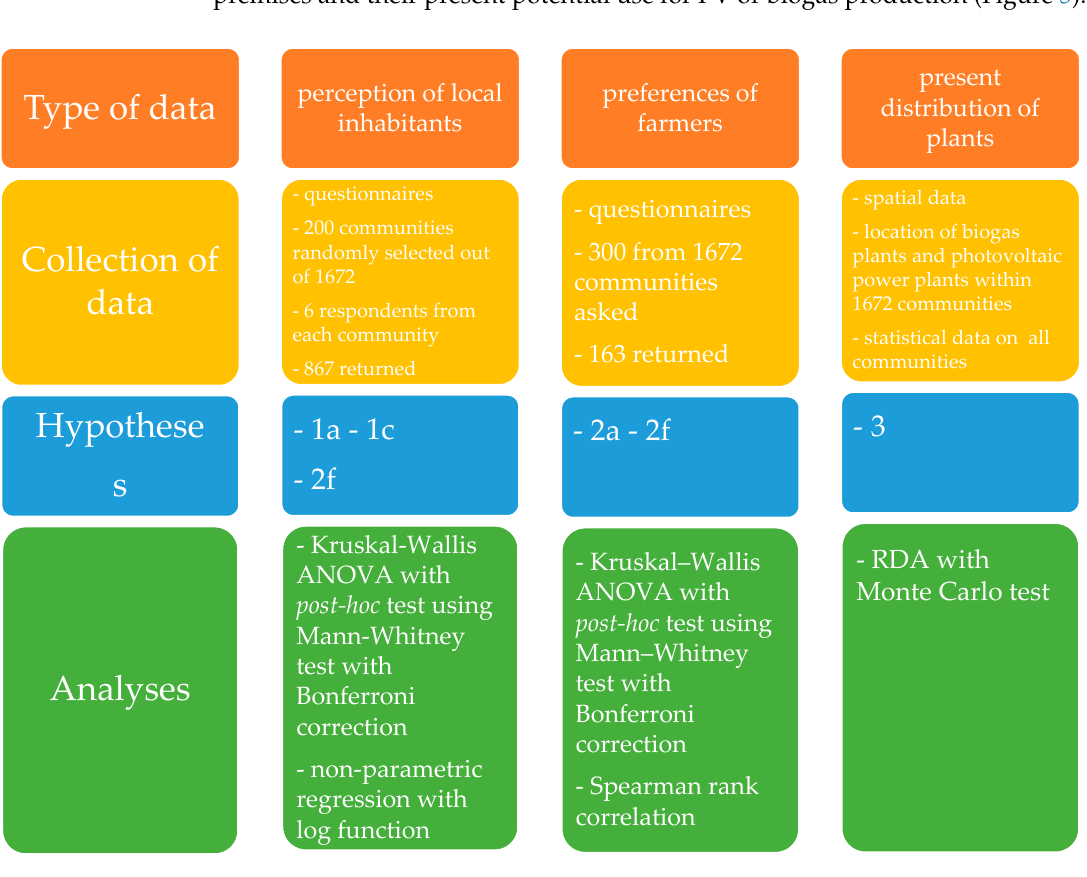
Figure 5. Research strategy.